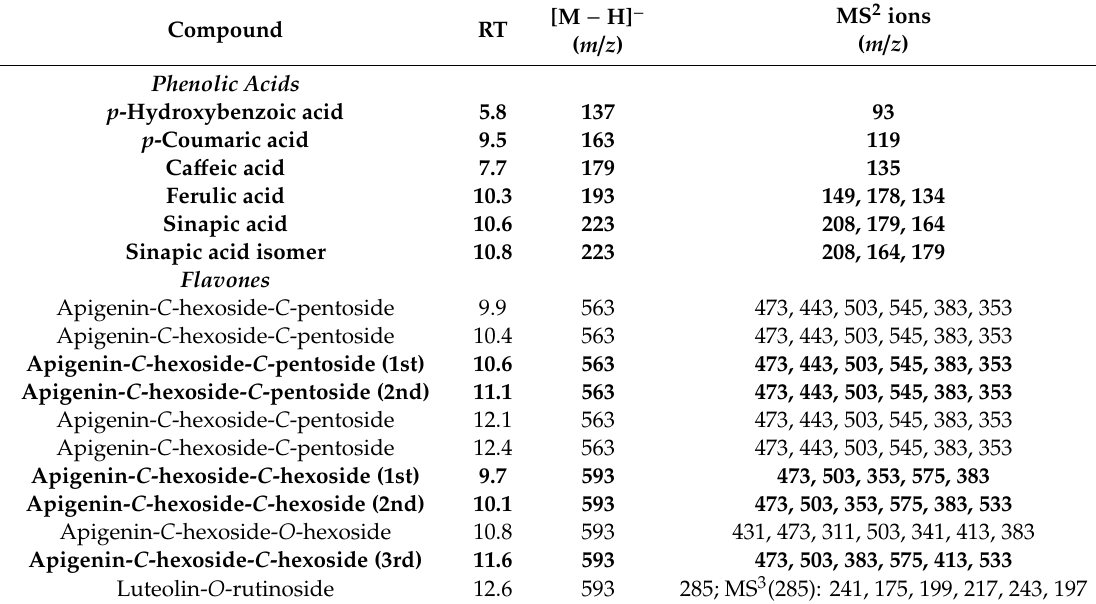
Table 1. Chromatographic and mass spectral characteristics of the free PCs identified in the experimental